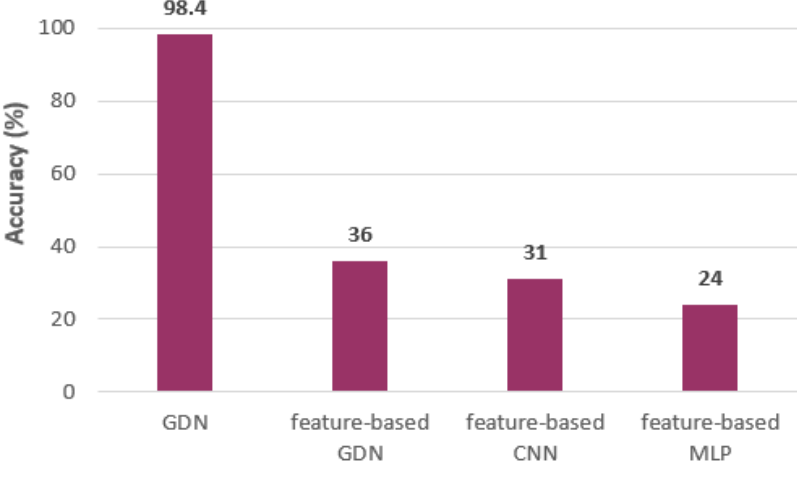
Figure 13. Comparison between feature-based classical